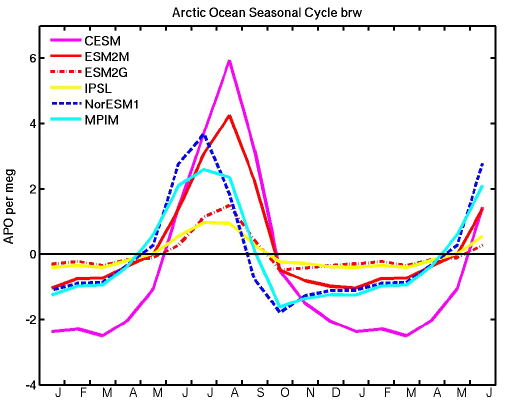
Figure 10. Annual mean CO 2 uptake in the Southern Ocean for 1997–2005 integrated from 44–75 ◦ S and plotted vs. mean APO amplitude at Macquarie Island (MQA) over the same period, as predicted by six ESMs. Independent estimates of carbon uptake from ocean inversions and observed p CO 2 databases (Lenton et al., 2013), plotted against the observed APO amplitude at MQA are shown for